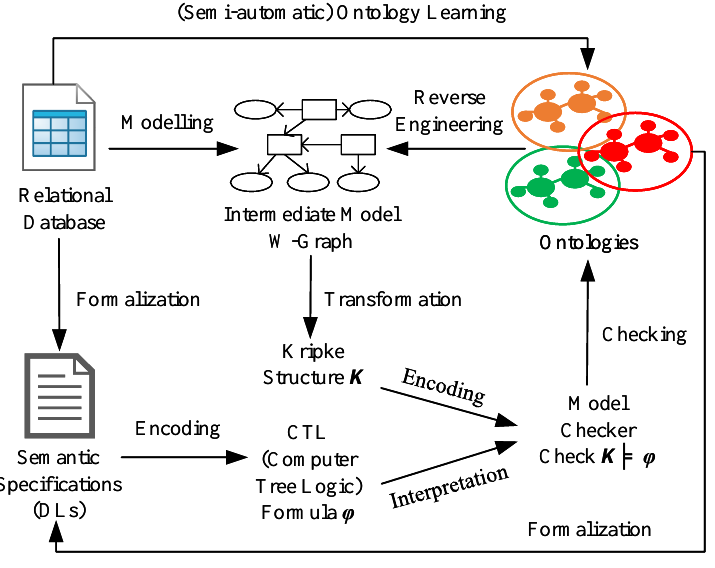
Figure 1. Semantic consistency checking for learning ontology from relational